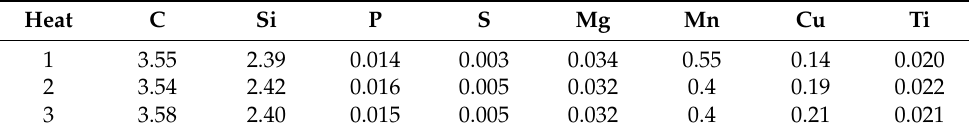
Table 3. Chemical compositions (% mass) of experimental cast irons. Heat